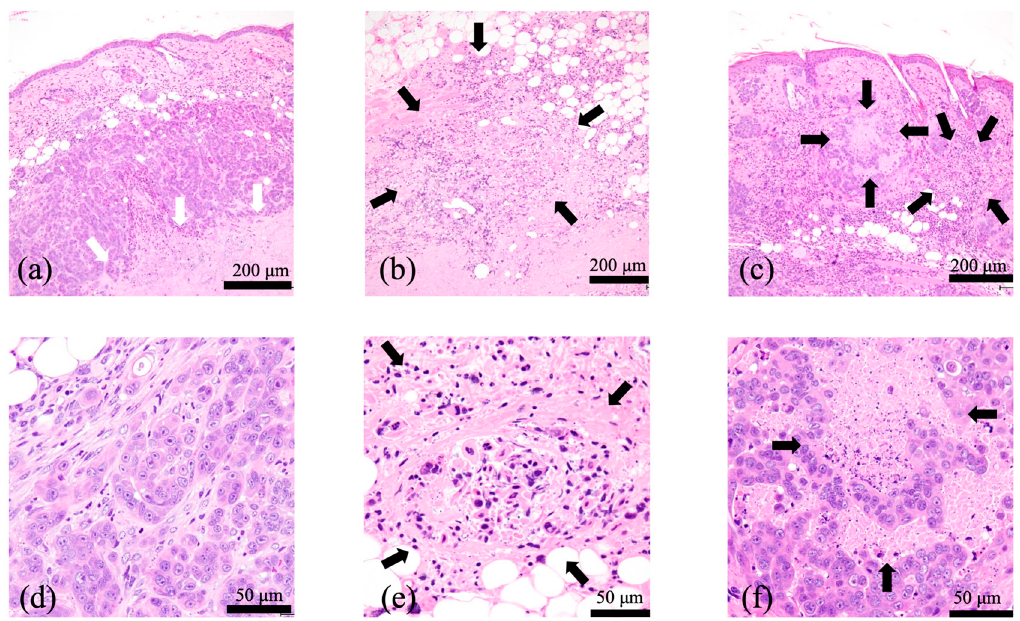
Figure 14. Representative hematoxylin & eosin stained images of the SNP tumors after photodynamic therapy (PDT). ( a , d ) Untreated tumors. Tumor cells infiltrated the dermis and necrotic tumor cells occupied the center region of the tumors (white arrows). ( b , e ) At 24 h after the 5-min-interval PDT. Widespread tumor cells appeared necrotic (black arrows). ( c , f ) At 24 h following the 3-h-interval PDT. Tumor cells at the superficial tumor tissue appeared necrotic (black arrows), whereas deep-seated tumor cells appeared intact. Widespread tumor cells appeared necrotic. ( a – c ) Scale bar = 200 µ m. ( d – f ) Scale bar = 50 µ m.